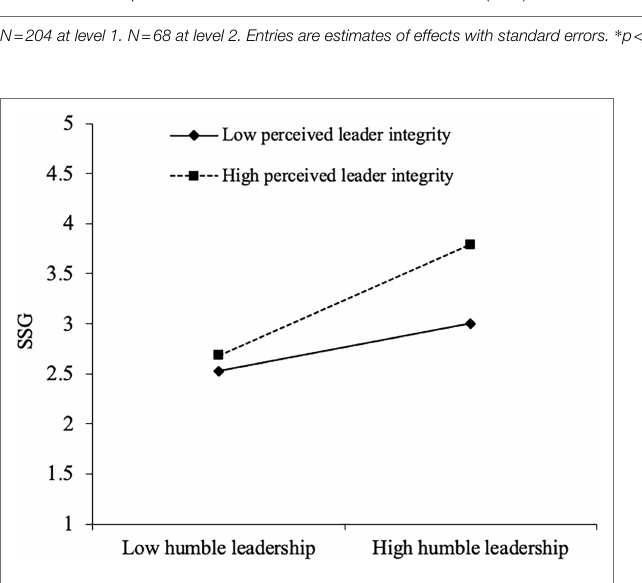
FIGURE 2 | The moderating effect of leader